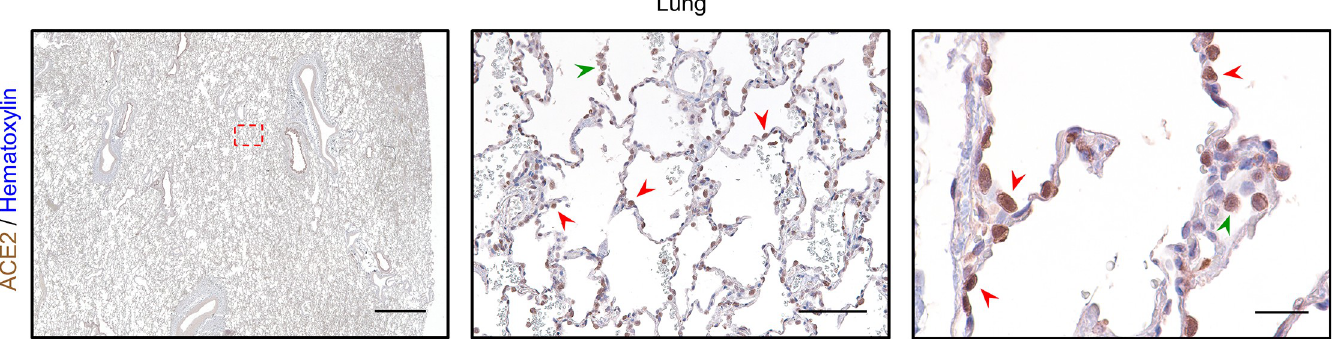
Fig 2. IHC for ACE2 highlights AT2 cells and alveolar macrophages in normal lung. In normal human lung from a 23-year-old female using a 1x objective (left, scale bar 3mm), strong ACE2 expression is observed within bronchioles and alveoli. The region outlined by the red dashed box is shown magnified at low power (middle, scale bar 200 μ m) which highlights prominent ACE2 expression in AT2 cells (red arrowheads) along the alveolar septum and in alveolar macrophages (green arrowhead). At high power (right, scale bar 50 μ m), ACE2 staining can be seen concentrated along the membrane of AT2 cells (red arrowheads) and within the cytoplasm of an alveolar macrophage (green arrowhead). Sections were stained for ACE2 using DAB and counterstained with hematoxylin.